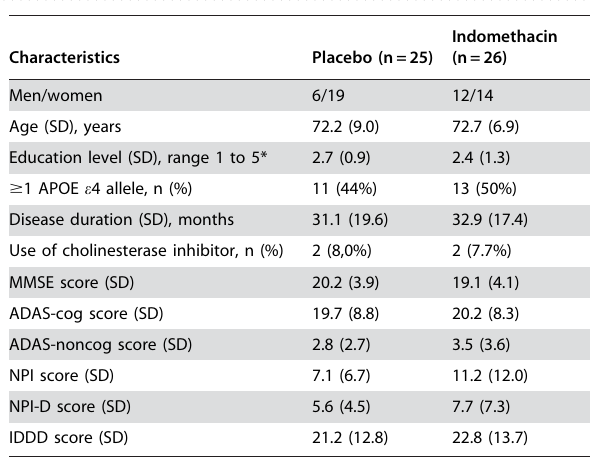
Table 1. Baseline characteristics of the study population